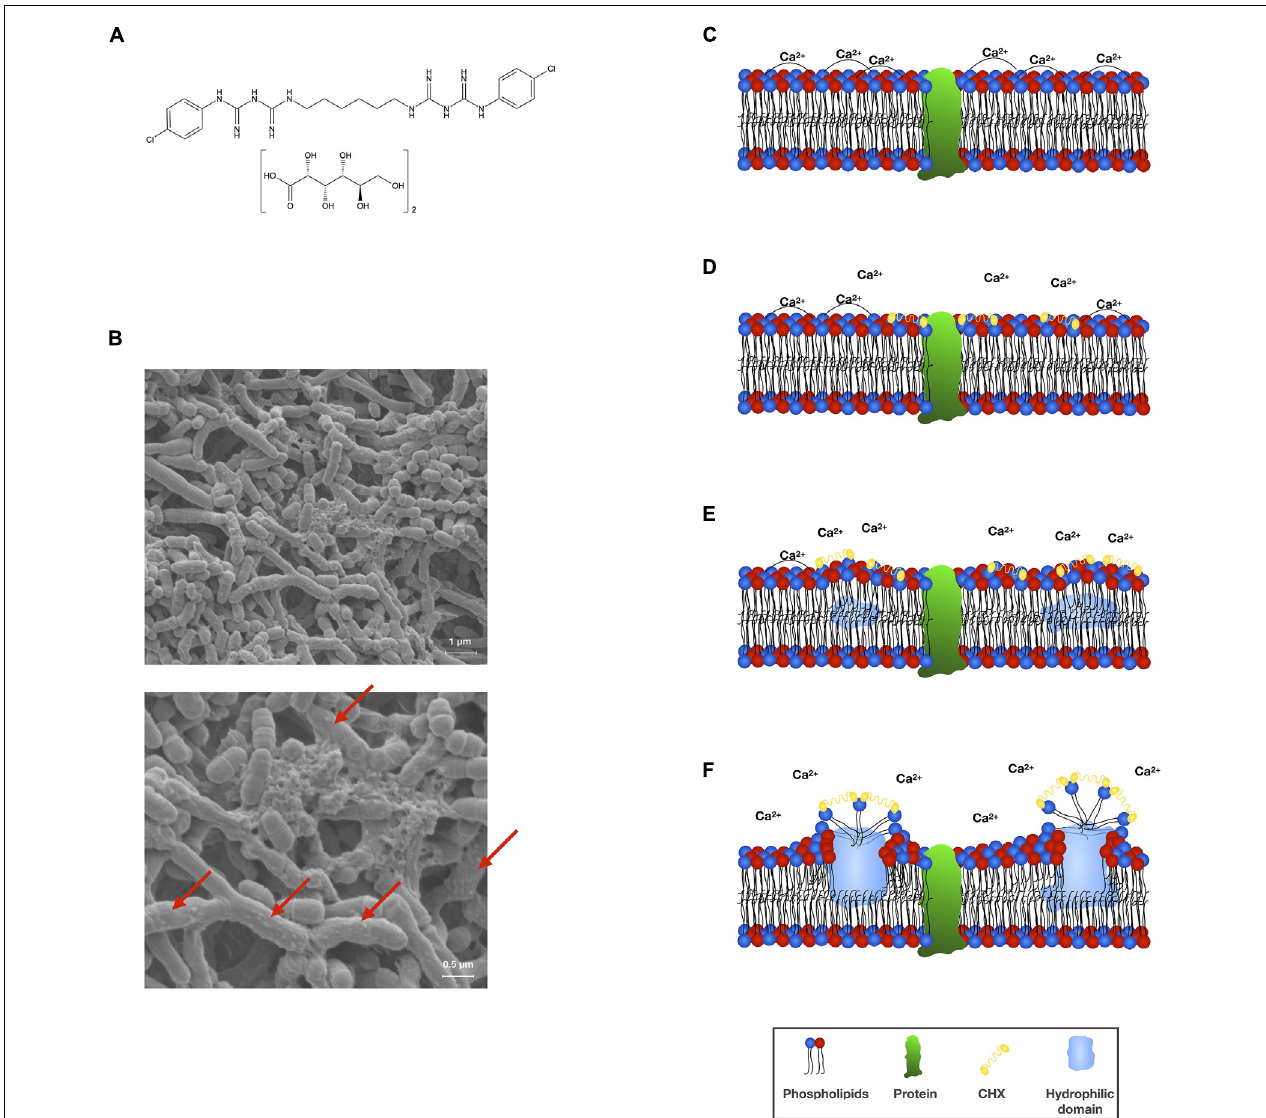
FIGURE 1 | (A) Chemical structural formula of CHX digluconate. (B) Scanning electron microscopic (SEM) visualization of an in vitro polymicrobial biofilm comprising Actinomyces naeslundii , Actinomyces odontolyticus , and S. mutans (methodology as described in Cieplik et al., 2018b,c) following treatment with CHX (0.2%; 10 min). Vesicle-like structures on the surfaces of bacterial cells indicate membrane damage (indicated by red arrows). SEM images are reprinted from Cieplik et al. (2018b). (C–F) Scheme depicting the mode of action of CHX toward bacterial cytoplasmic membranes. The bacterial cytoplasmic membrane carries a net negative charge and is composed of a phospholipid bilayer with embedded proteins. The phospholipid bilayer is stabilized by divalent cations such as Ca 2 + and forms a hydrophobic environment, which is essential to moderate the functionality of the embedded proteins (C) . CHX (as a cationic agent) binds to the negatively charged bacterial cell surface and initially interacts with the cytoplasmic membrane. Thereby, CHX bridges between pairs of phospholipid headgroups and displaces the associated divalent cations (D) . Progressive decrease in fluidity of the outer phospholipid layer with creation of hydrophilic domains within the bilayer affecting the osmoregulation and metabolic activity of the cytoplasmic membrane and its associated enzymes (E,F) . This scheme was adopted and modified from Gilbert and Moore